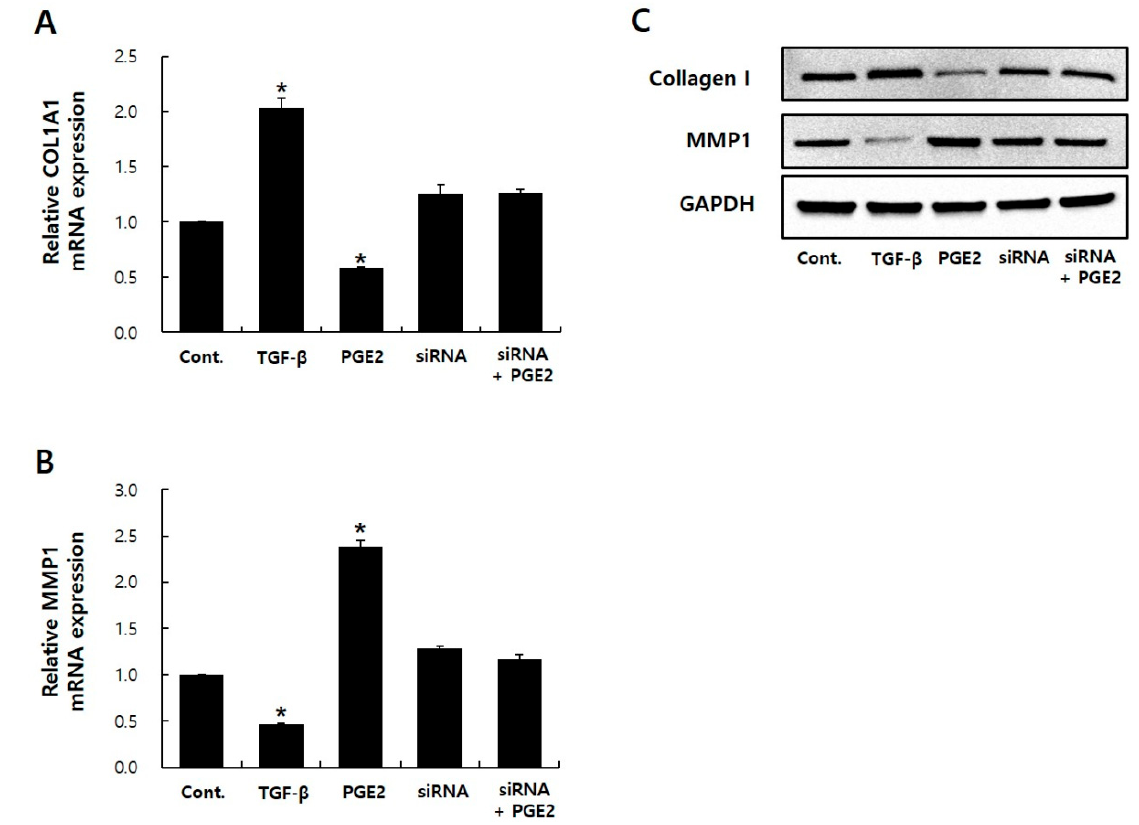
Figure 4. EP1 siRNA blocks PGE2 effects on COL1A1 and MMP1 expression in NHDFs. COL1A1 ( A ) and MMP1 ( B ) expression was estimated by qRT-PCR. Immunoblotting analysis for Collagen I and MMP1 ( C ). TGF- β was used as a positive control. The error bar represents the SD of independent experiments. * p < 0.05 compared to the control. siRNA, small interfering RNA.